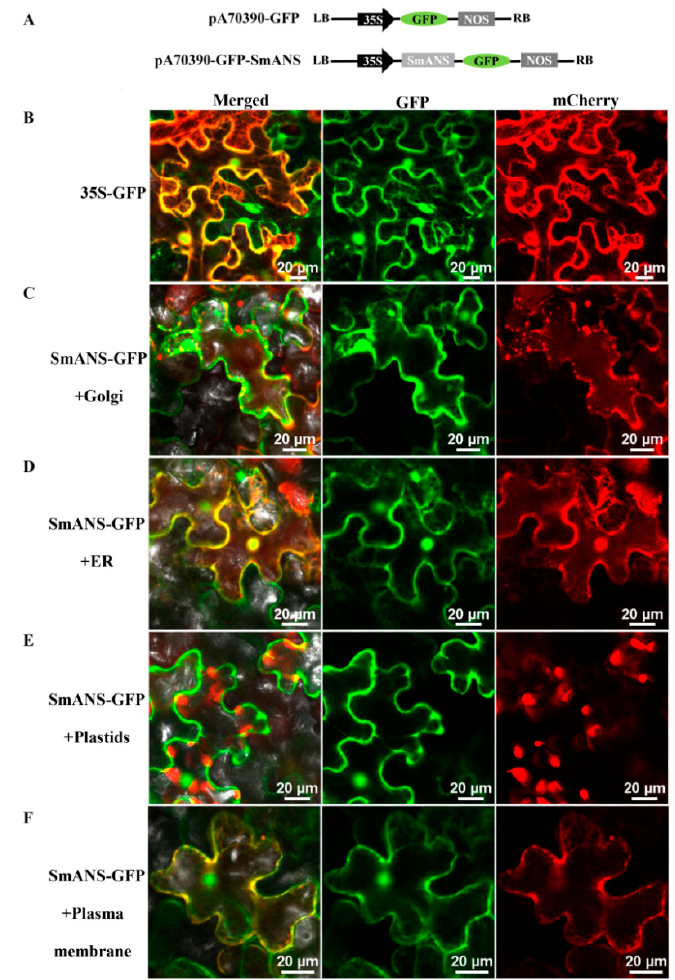
Figure 3. Subcellular localization of SmANS in Nicotiana benthamiana leaf epidermal cells. ( A ) Schematic representation of recombinant vector pA70390-GFP-SmANS; ( B ) Subcellular localization of pA70390 with the control (no SmANS inserted); ( C – F ) Golgi, endoplasmic reticulum (ER), plastids, and plasma membrane localization of PA70390-GFP-SmANS in N. benthamiana leaves epidermal cells (SmANS inserted), respectively. Merged, the overlapping field of GFP and mCherry. GFP, green fluorescent field. mCherry, red fluorescent channel field of Golgi, ER, plastids, and plasma membrane marker. Scale bars, 20 μ m.